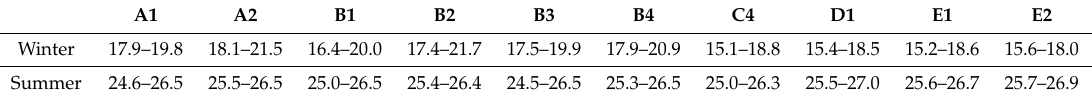
Table 7. Acceptable temperature range in winter for waiting lounge (Unit: ◦ C).